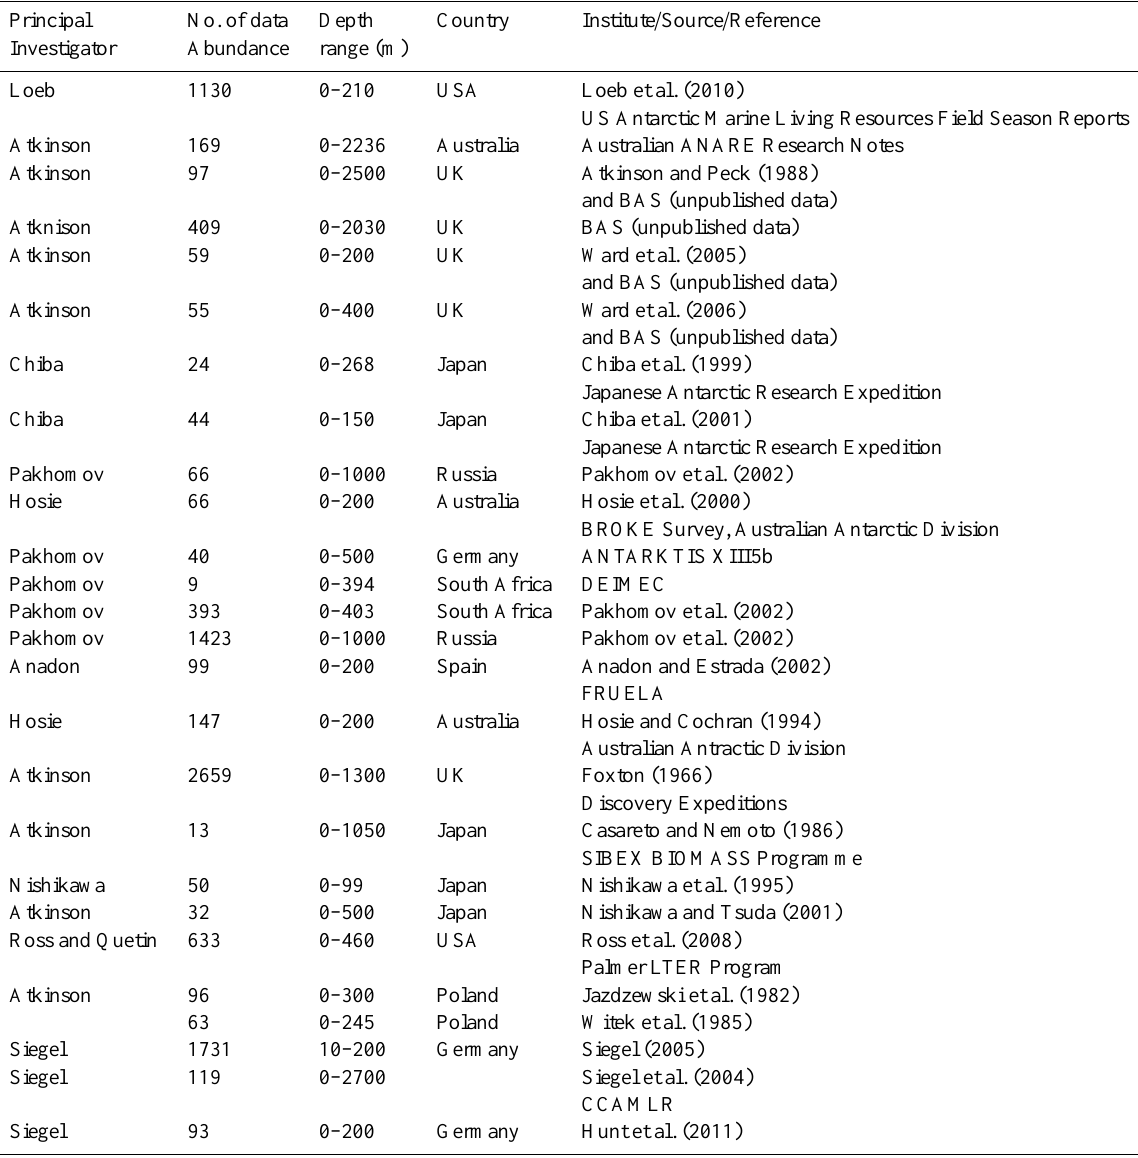
Table 1c. Summary of data points for Salpa thompsoni and Ihlea racovitzai abundance in the Southern Ocean from the rawKRILLBASE dataset (Atkinson et al.,